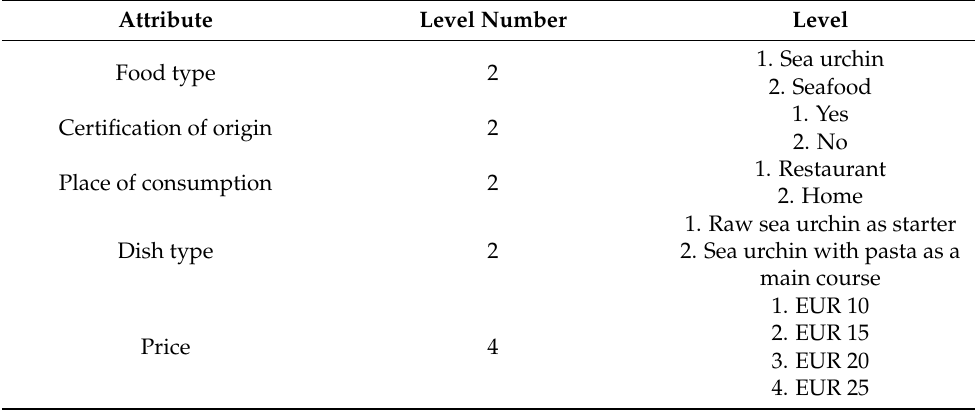
Table 1. Attributes and levels used to elicit Italian sea urchin consumers’ preferences in the survey. Attribute Level Number Level Food